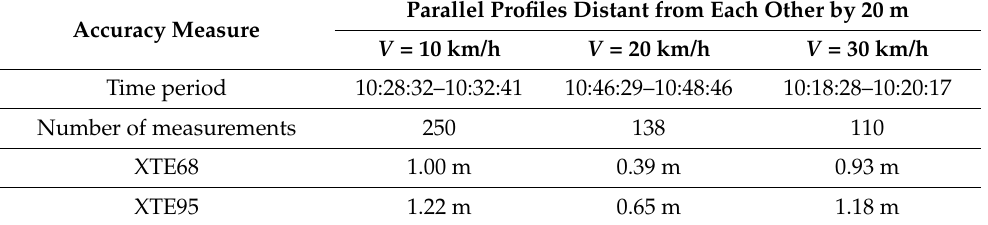
Table 4. The accuracy measures of steering a UAV for the route comprising parallel profiles distant from each other by 20